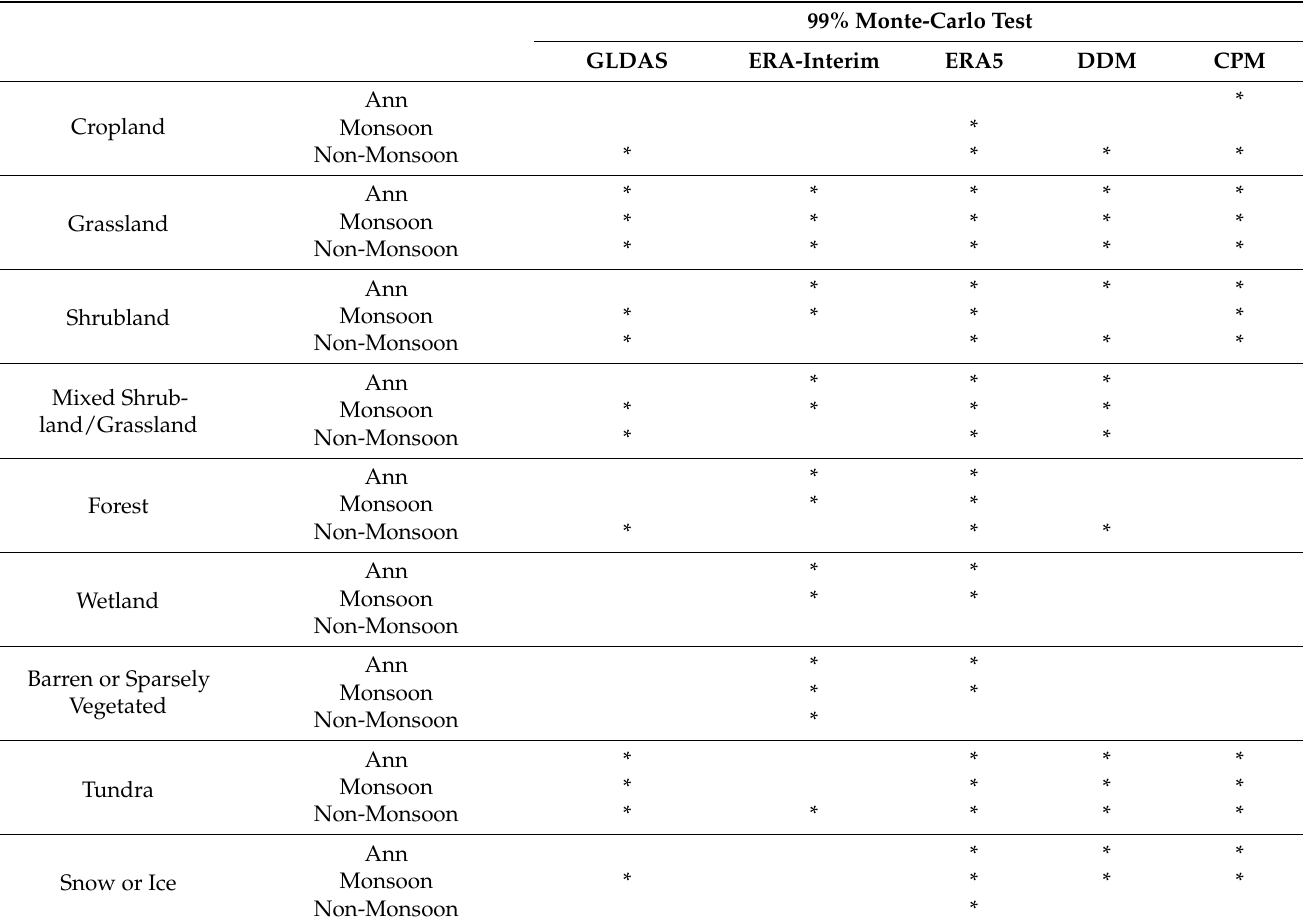
Table 4. The Monte-Carlo significance test of ET at confidence level of 99% over nine land-use categories of GLDAS, ERA-Interim, ERA5, DDM, and CPM compared to EB. * Indicates that the value has passed the 99% significance test, which means the ET is significantly different from that of EB over the corresponding land-surface